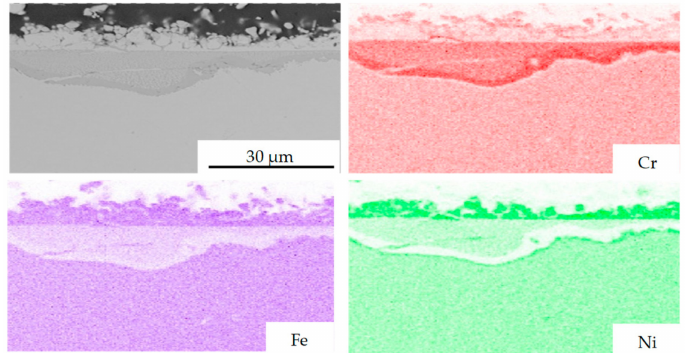
Figure 7. SEM cross section of Alloy 800H (100 h, 750 ◦ C, 6 MPa helium) formation of layers in the substrate by di ff usion of elements (Cr, Fe, and Ni).